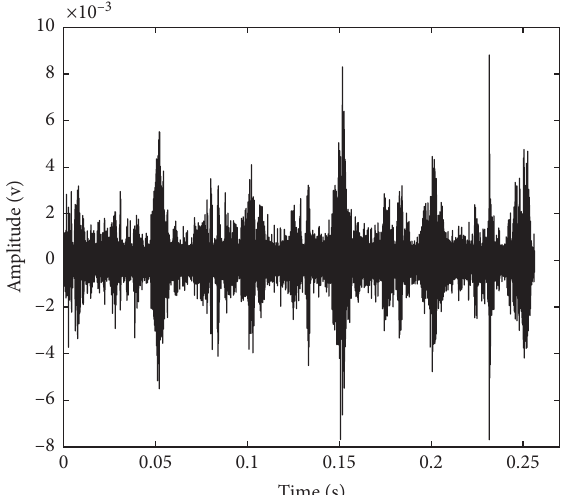
Figure 10: The denoised signal for small defect with condition of small load and speed of